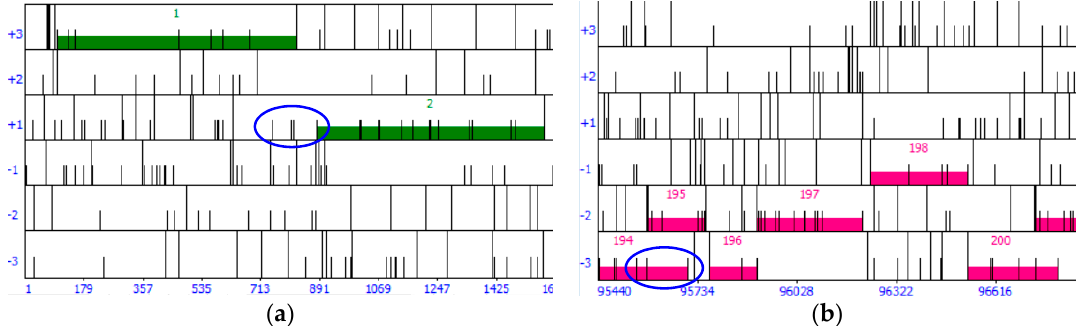
Figure 8. ( a ) For forward genes, such as gene 2, the overlap of each start codon considered (circled in blue) is calculated by subtracting each start codon from the stop codon of gene 1; ( b ) for reverse genes, such as gene 194, the overlap of each start codon evaluated (circled in blue) is calculated by subtracting the stop codon of gene 195 from each start codon of gene 194. To save time and effort, only start codons that produce a long ORF are evaluated, e.g., the majority of gene 2 ′ s start codons in panel (a) are not evaluated.